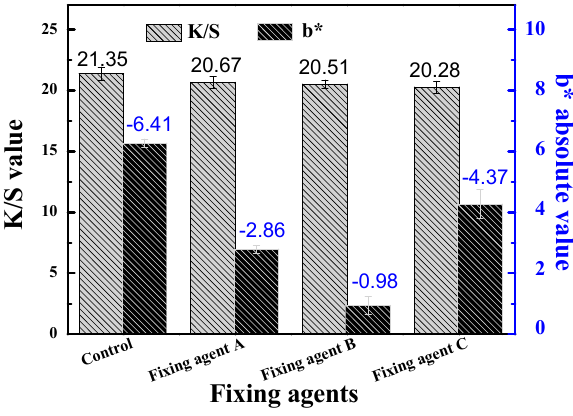
Figure 5. K / S value and rubbing fastness of fixed cotton